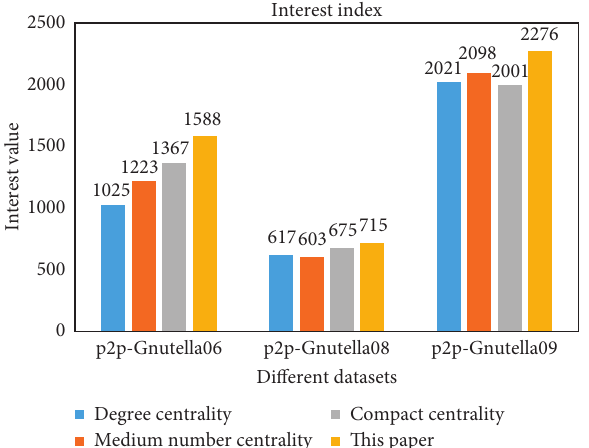
Figure 8: Interest index comparison of different methods.